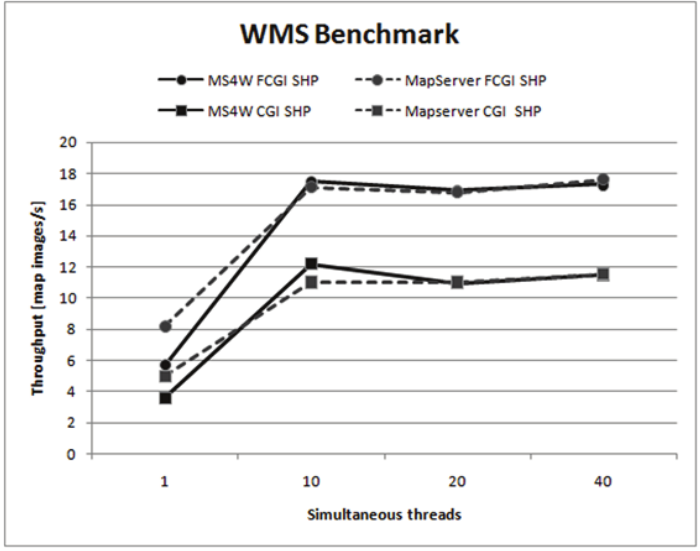
Figure 2: WMS results under various conditions (OWS implementation and file